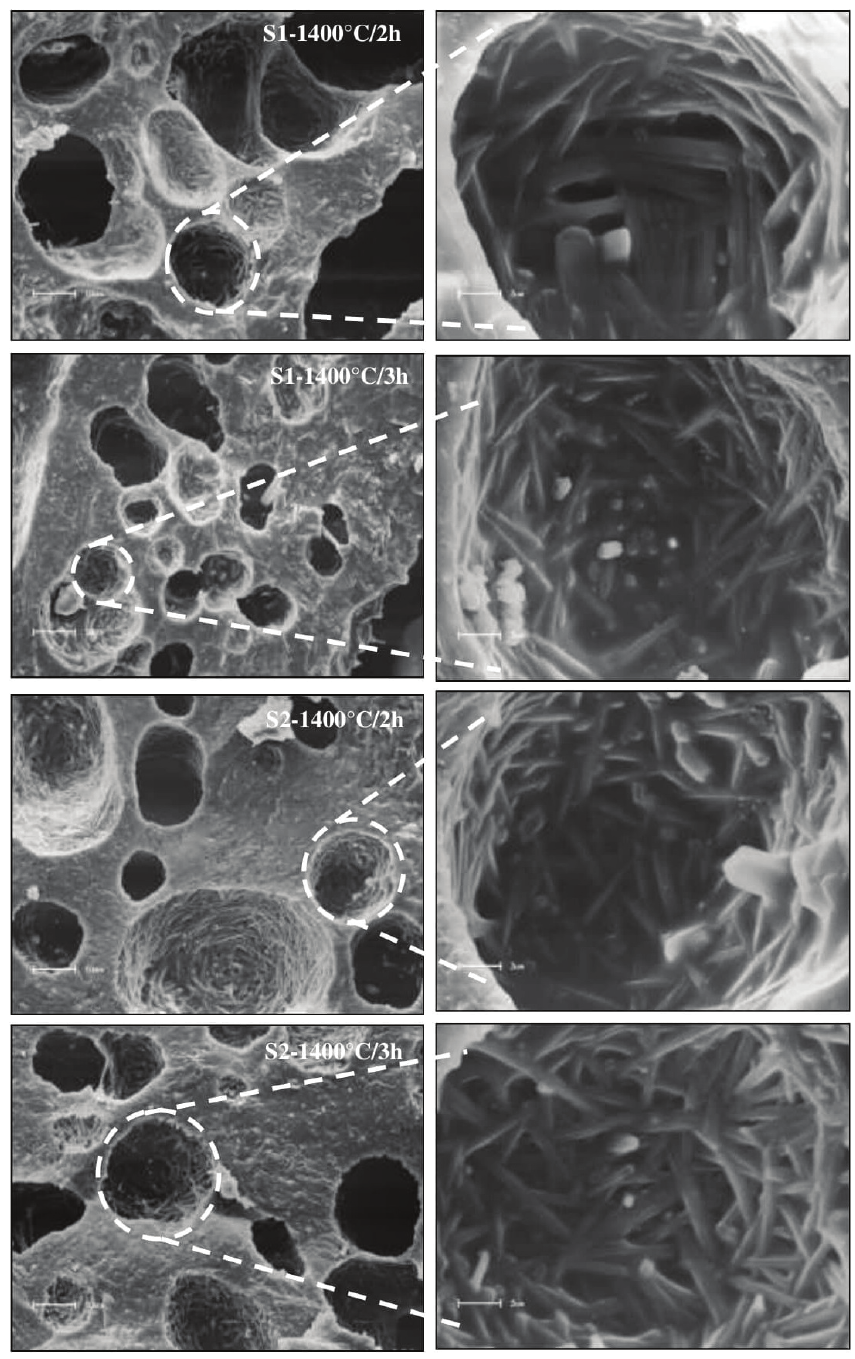
Figure 5. SEM micrographs of the fracture surface of specimens obtained from formulations S1 and S2 sintered at 1400ºC with dwell times of 2 and 3